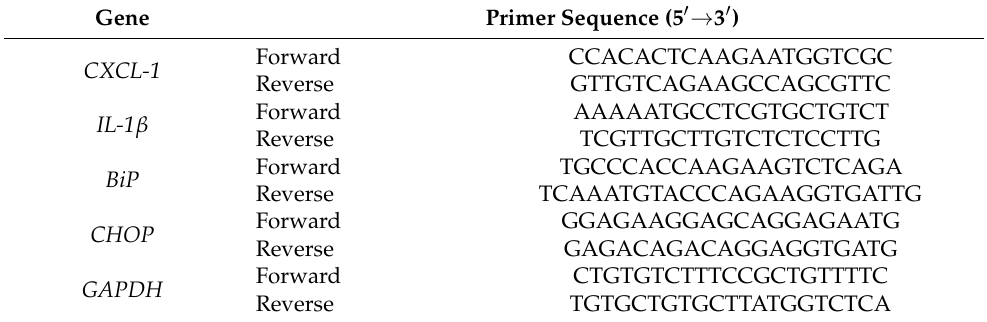
Table 3. Quantitative reverse transcription-polymerase chain reaction (qRT-PCR) primer sequences. Gene Primer Sequence (5 (cid:48) → 3 (cid:48) )